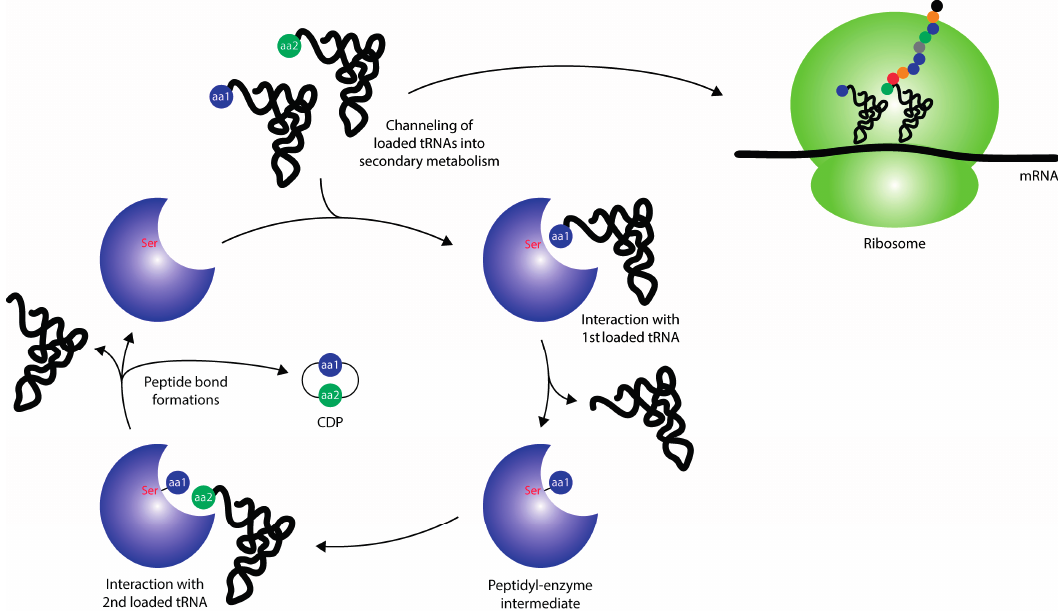
Figure 1. Overview of the general action of CDPSs (cyclodipeptide synthases) and their connection to primary metabolism. CDPSs hijack aminoacyl-tRNAs and employ them in the formation of CDPs (cyclic dipeptides), thus diverting the flow of loaded tRNAs away from the ribosomal machinery. Adapted from [31] with permission of The Royal Society of Chemistry, copyright 2012.